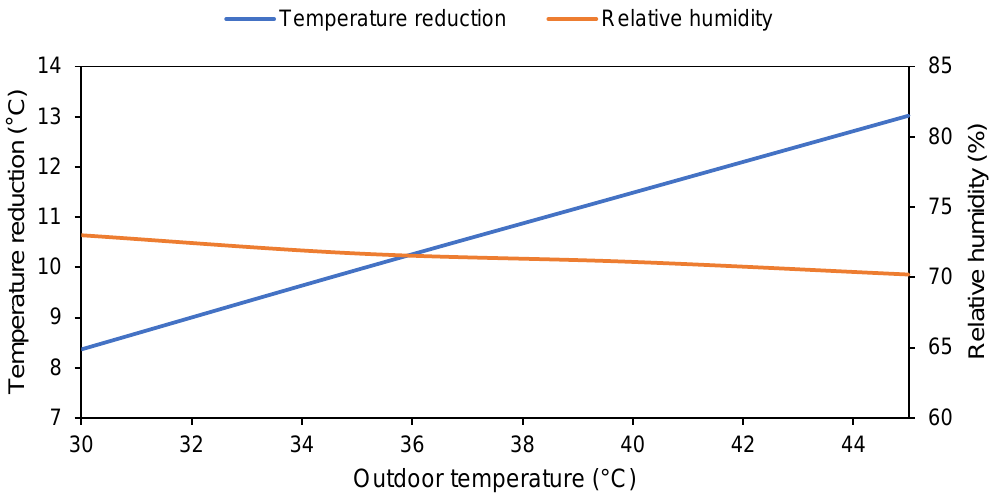
Figure 12. The influence of varying outdoor temperatures on the temperature reduction and indoor relative humidity (ambient relative humidity = 24.4%, U HWC = 4.4 m / s at windcatcher roof